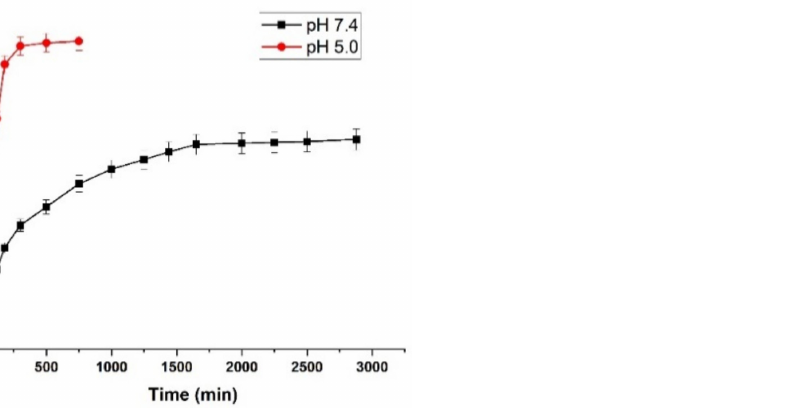
Figure 9. DOXO release profiles from DOXO@ DEX/CUR at pH 5.0 (red line) and pH 7.4 (black lines). Data were reported as mean values ± SD of three independent experiments.